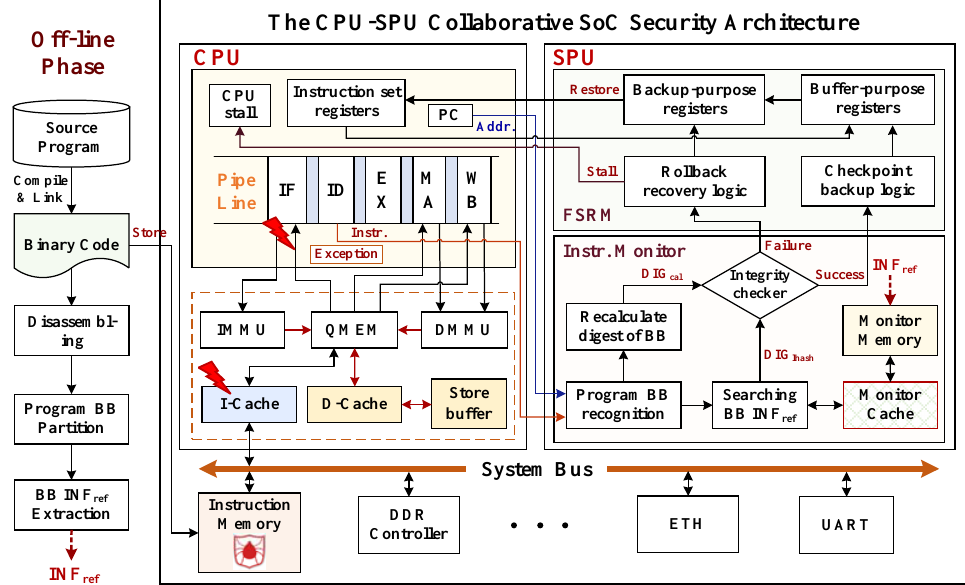
Figure 1. The CPU–SPU collaborative SoC hardware architecture for real-time security